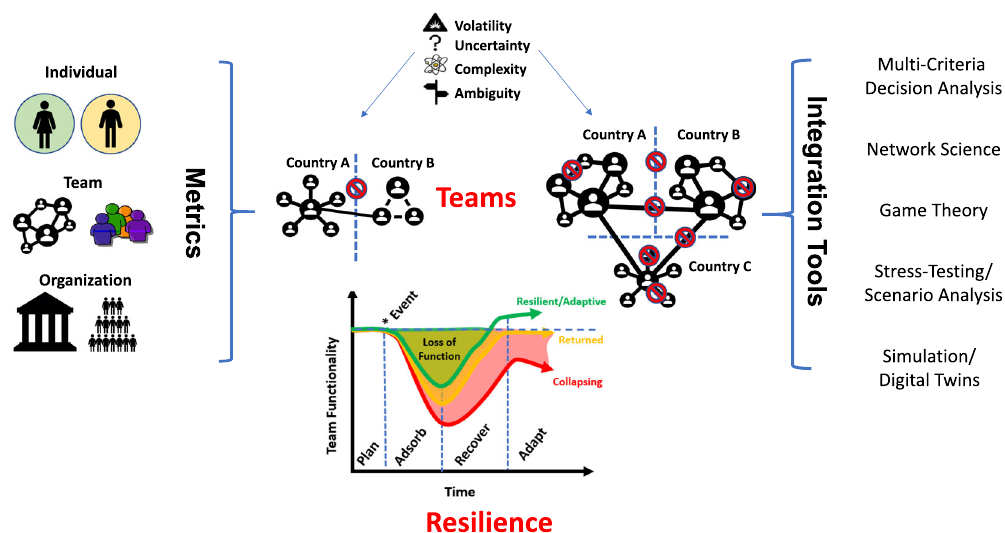
Fig. 1 Blueprint of our current dilemma. Both small and large international research teams lack resilience to diverse disruptions that incorporate volatility, uncertainty, complexity, and ambiguity (Helbing, 2013). While many disciplines have de fi ned and applied local-scale metrics to individuals, teams and institutions, few integrative tools can translate these diverse lines of evidence into actions that create resilient international teams that can respond to different challenges over a project ’ s functional